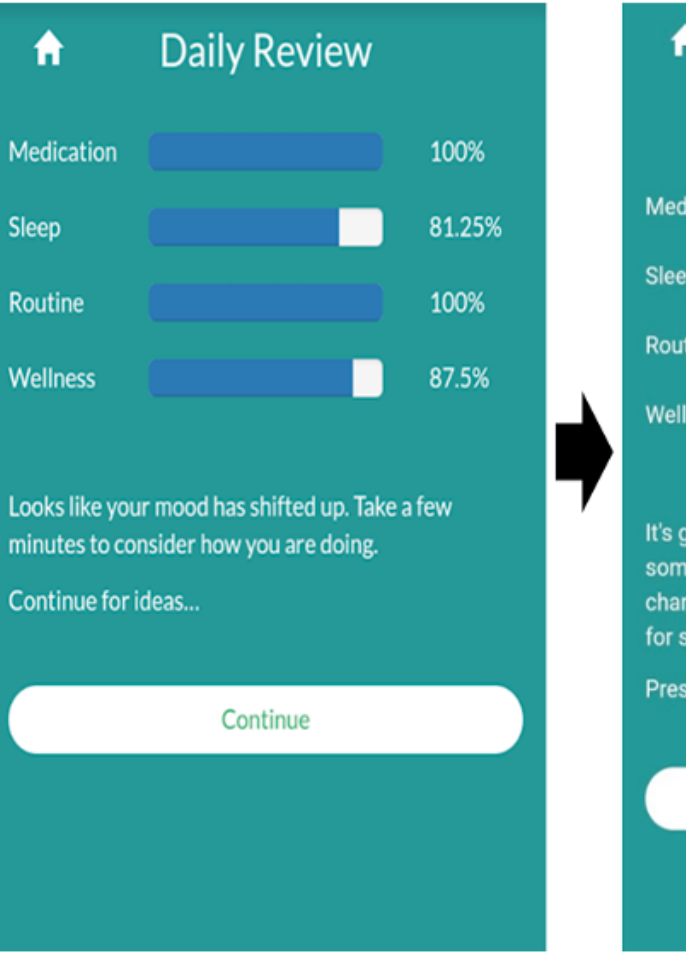
Figure 3. Daily Review